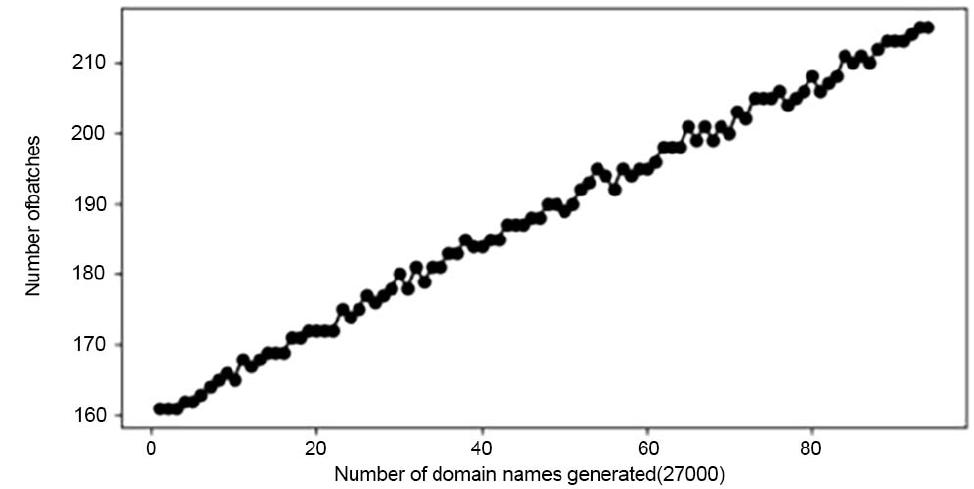
Figure 11. Changes in the number of batches required to generate the same number of new domain names.